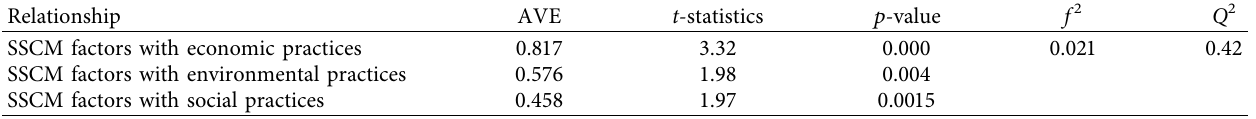
Table 12: Signifcance analysis of the structural model relationships.